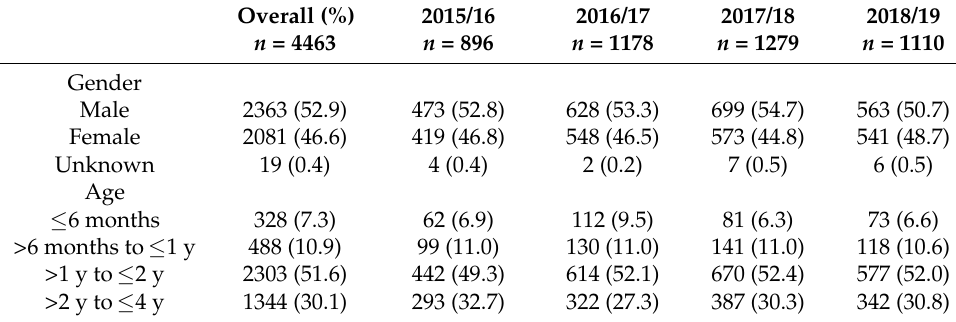
Table 2. Demographic information on specimens